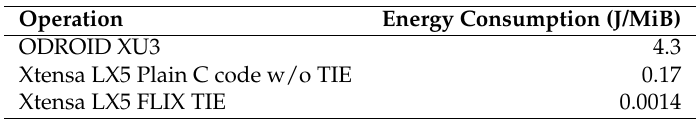
Figure 8. RLNC decoding throughput (in MiB/s = 2 20 Byte/s) comparison between ODROID XU3 with SIMD (NEON) instructions and Xtensa LX5 core with SIMD and FLIX TIE instructions for various generation sizes g and symbol (packet) sizes m in bytes. Table 2. Energy consumption for RLNC encoding followed by RLNC